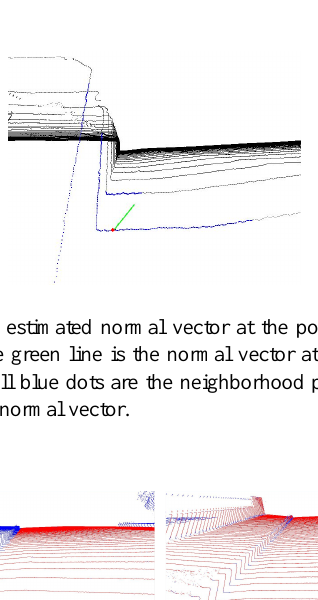
(b) The region exceeds the appropriate boundary.